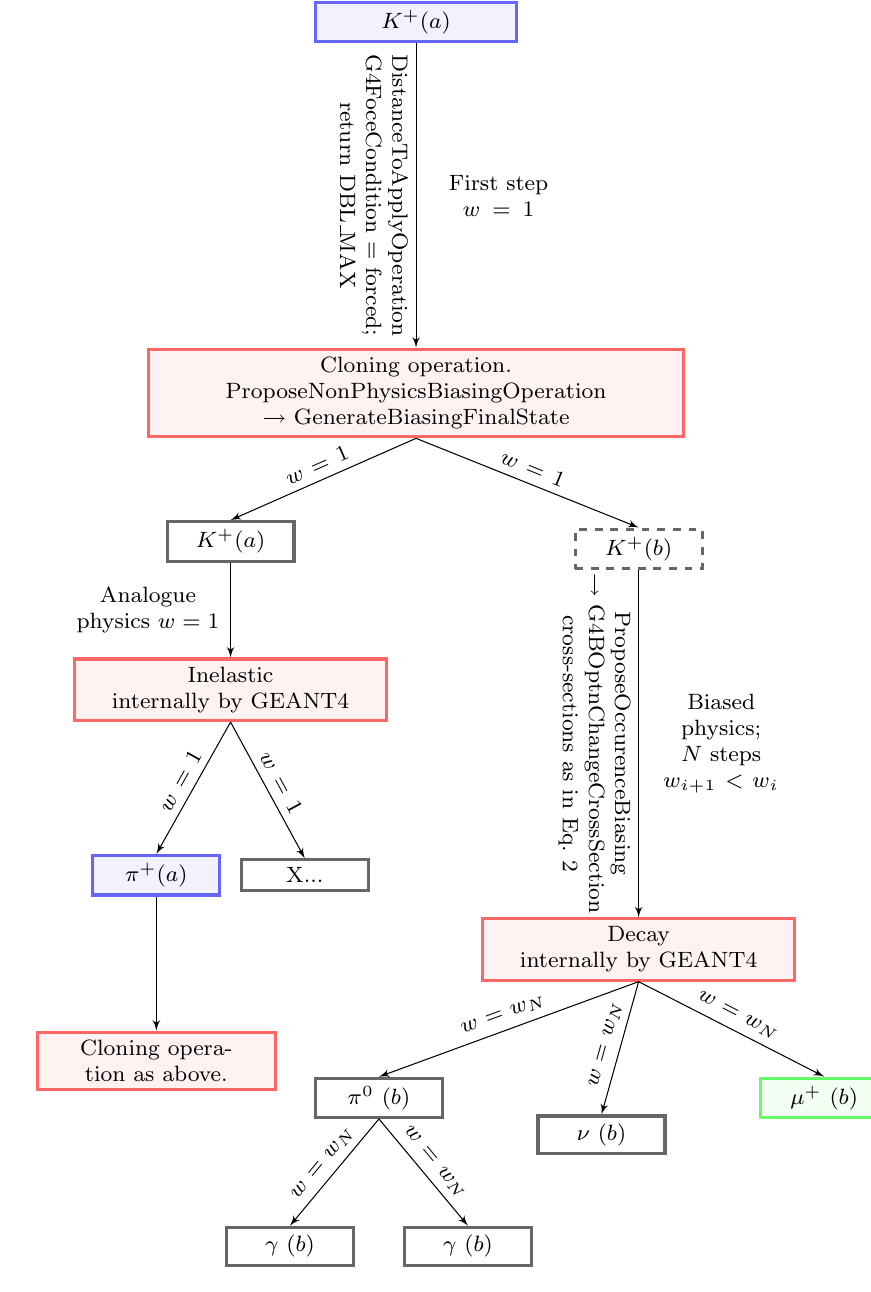
Fig. 1 Example of the biasing algorithm showing operations applied on analogue ( a ) and biased ( b ) particles. Particles to be cloned at the end of their first step are represented by blue rectangles. Solid black rectangles indicate particles undergoing analogue physics processes, but no cloning. Dashed rectangles are used for particles with modified cross-sections along their path. Particles to be kept at the end of the simulation are shown in green rectangles. The evolution of the weights ( w ) is also